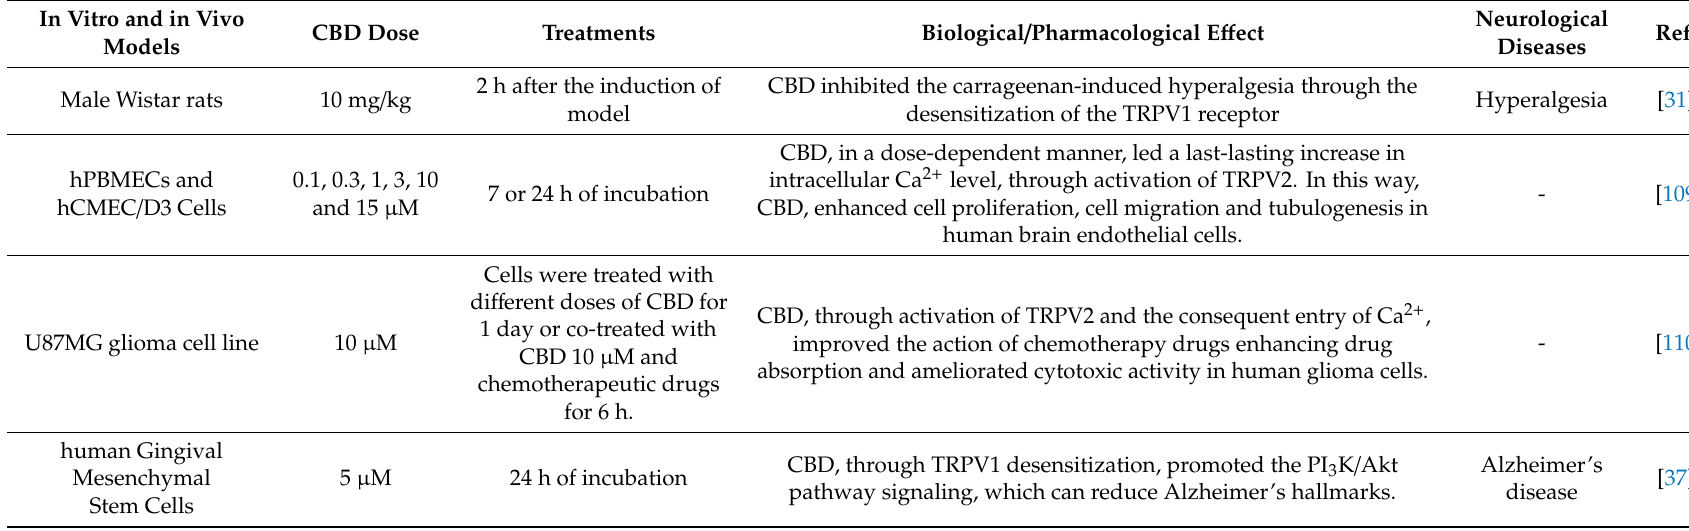
Table 4. Neuroprotective e ff ects of CBD in di ff erent neurological diseases through the activation of the TRPV